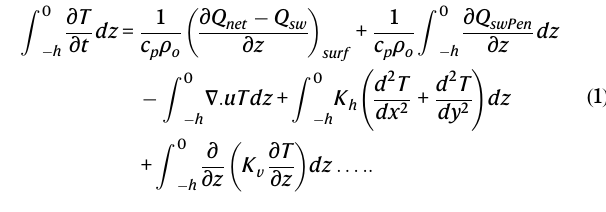
Fig. 6 | Schematic diagram of the Indian Ocean warming pattern mechanism. Ensemble mean of climatological G pattern (contours) during the period 1980 – 2000 and changes (future minus historical) in SST (shaded) for the 50 members of CESM2-LE. The negative values of G (dashed contours) represent strong negative feedback and thus a dampening of SST anomalies. A 15-year